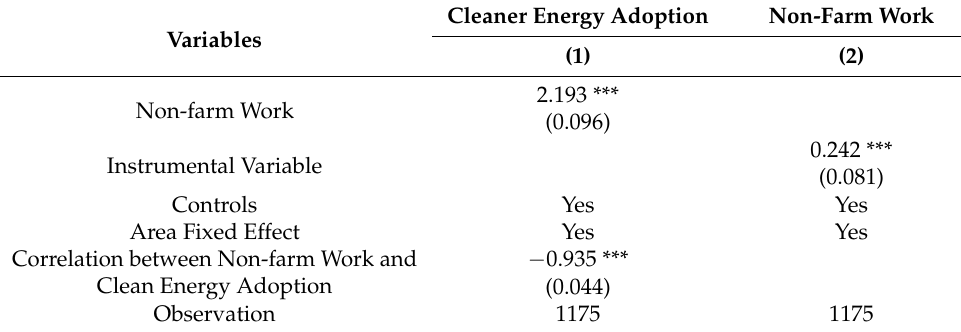
Table 3. Estimation Results Based on the ERM